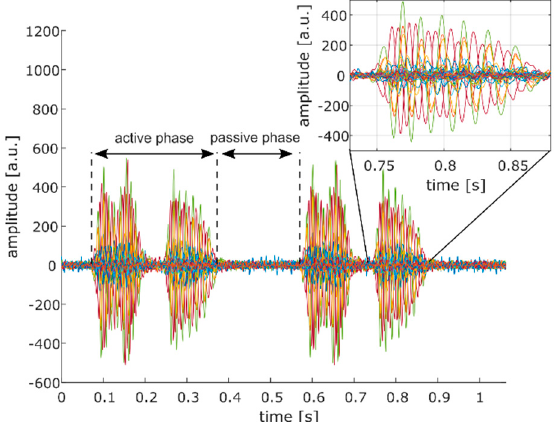
Figure 7. Definition of active and passive phase of the Doppler signal for the calculation of the SNR. Each colored line (37 in total) represents the Doppler signal of a single transducer element. The two events visible in the Doppler signal during the active phase correspond to forward and backward motion of the heart relative to the transducer. In the inset of the figure, strong phase variations of the different Doppler signals are visible.